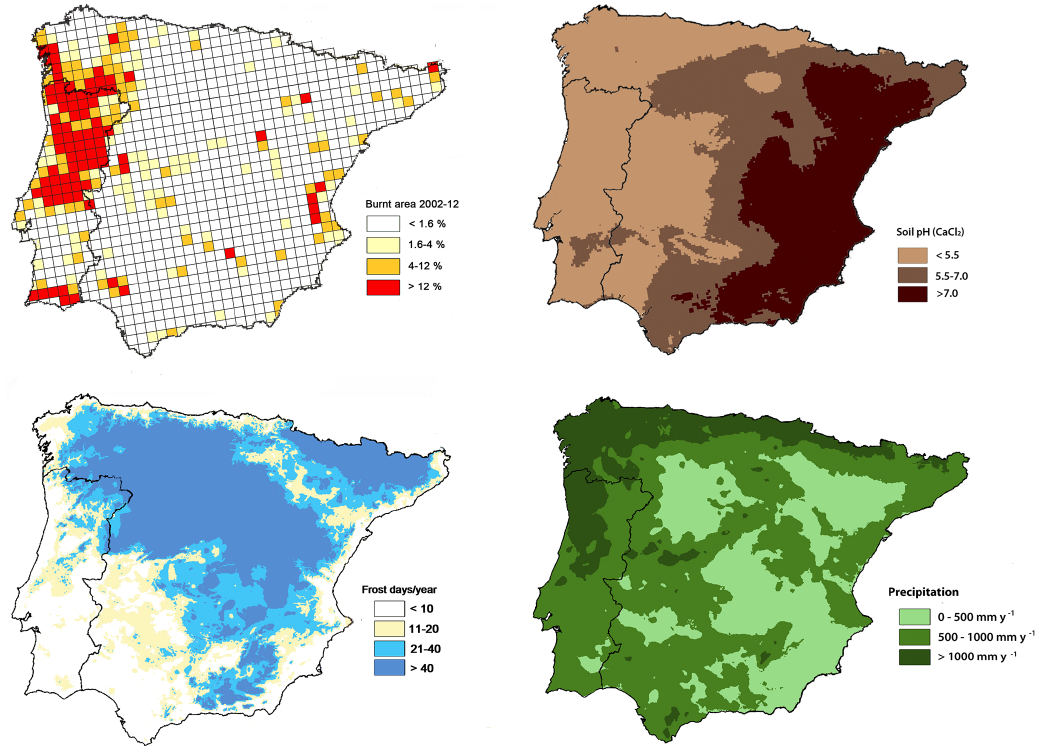
Figure 2. Maps of the Iberian Peninsula for several abiotic characteristics related to Acacia spread: burnt area during the period 2002–2012, adapted from Borrelli et al. (2016); soil pH, adapted from European Commission (2010); frost risk and annual precipitation, both adapted from AEMET-IMP